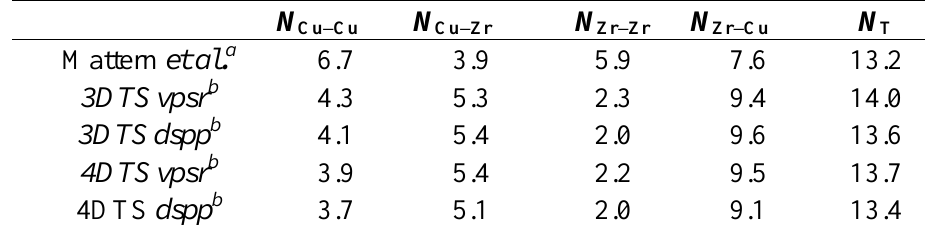
Table 6. Comparison of our total and partial coordination numbers with the experimental values of Mattern et al . [30].